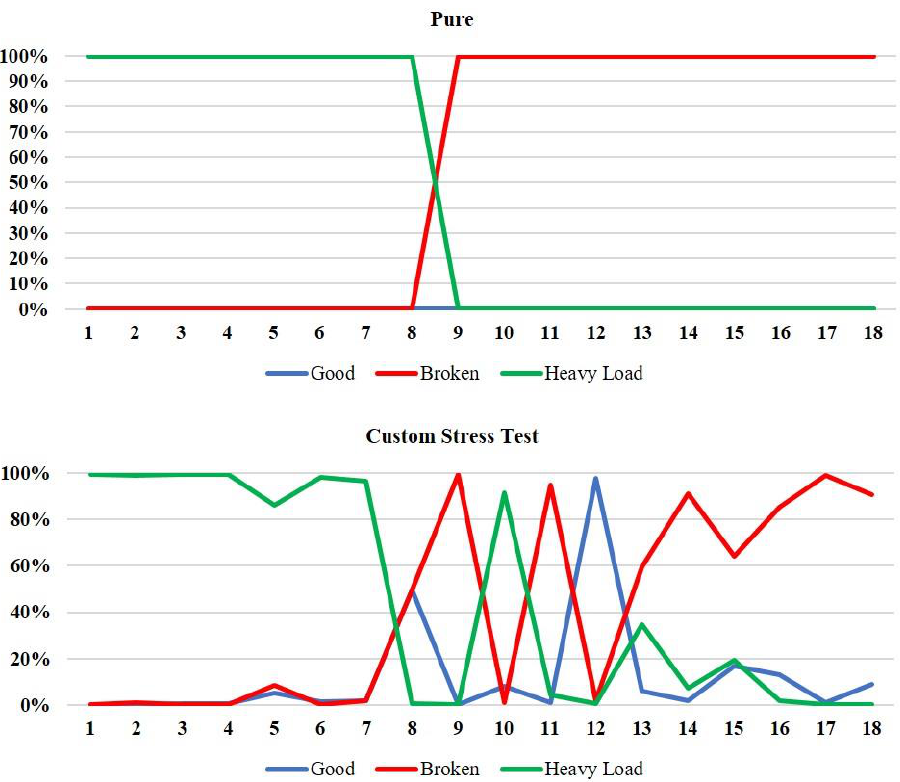
Figure 6. Performance of CNN model of the Edge Impulse’s methodology for the heavy load to broken state transition test.